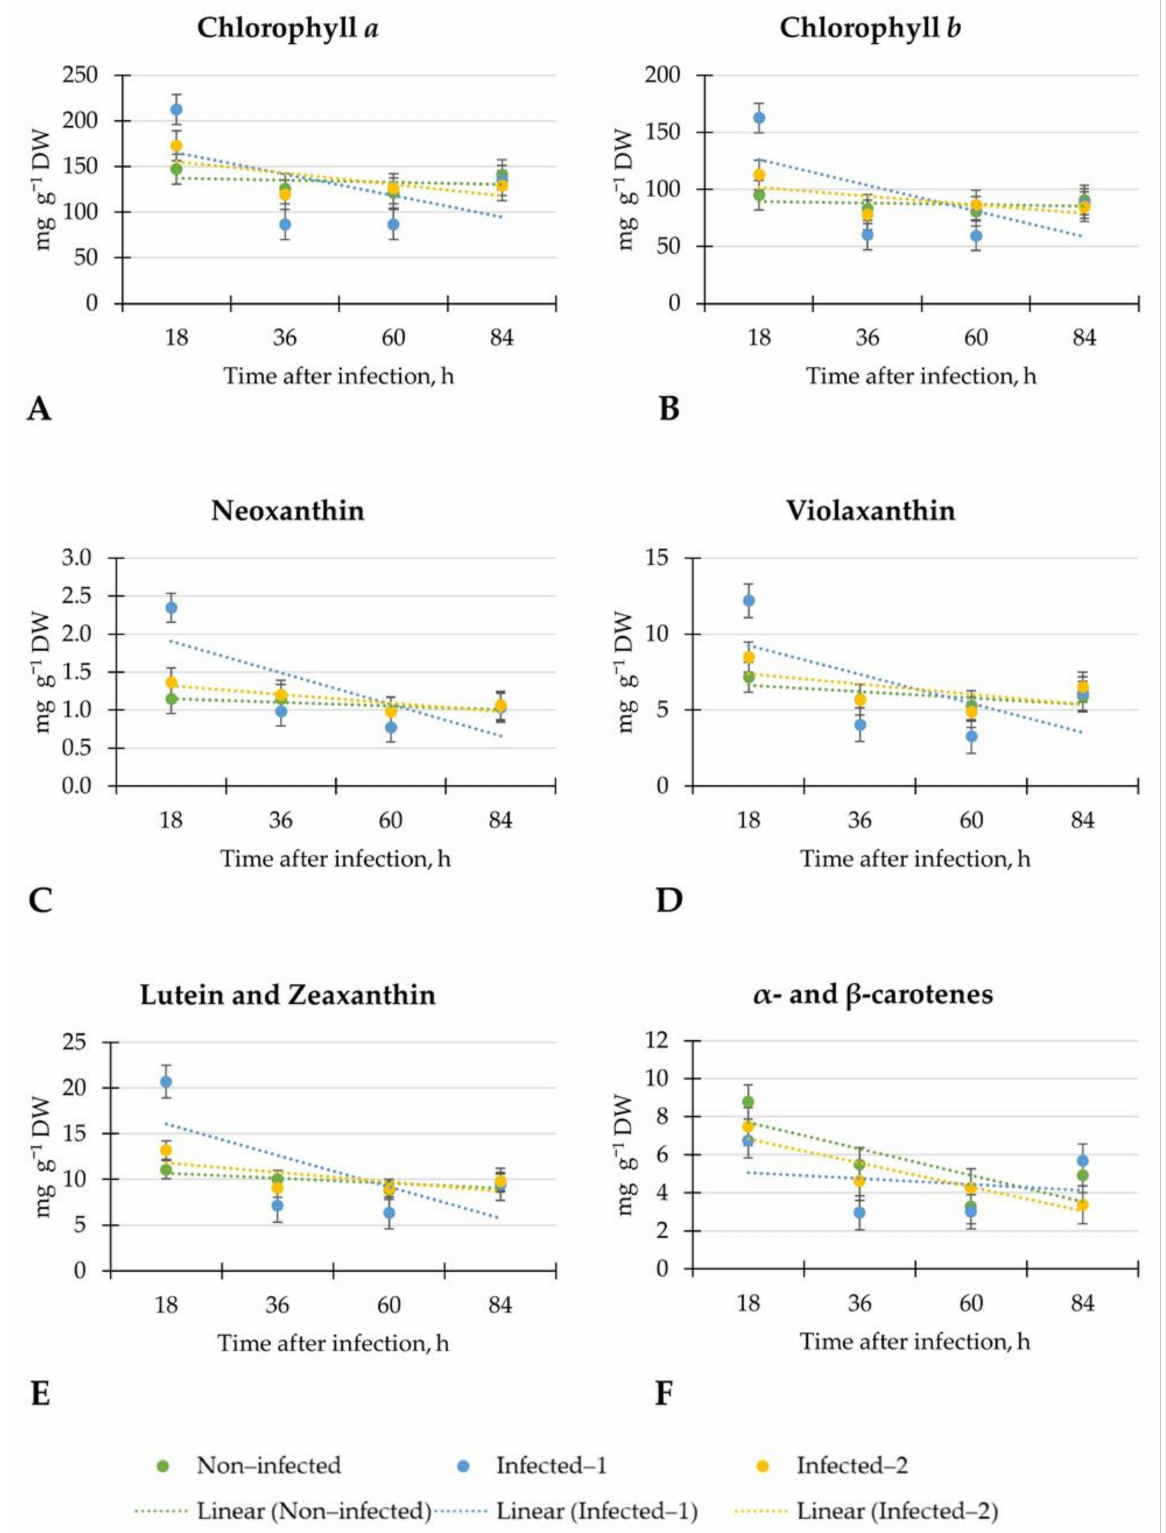
Figure 4. Biochemical measurements of the chlorophyll a ( A ) and b ( B ), neoxanthin ( C ), violaxanthin ( D ), lutein and zeaxanthin ( E ), and α - and β –carotenes ( F ) of non-infected, artificially infected with B. cinerea disc (Infected-1) and infected with pathogen spore suspension (Infected-2) of “Little Gem” lettuce after 12, 18, 36, 60, and 84 h of artificial infection. DW—dry